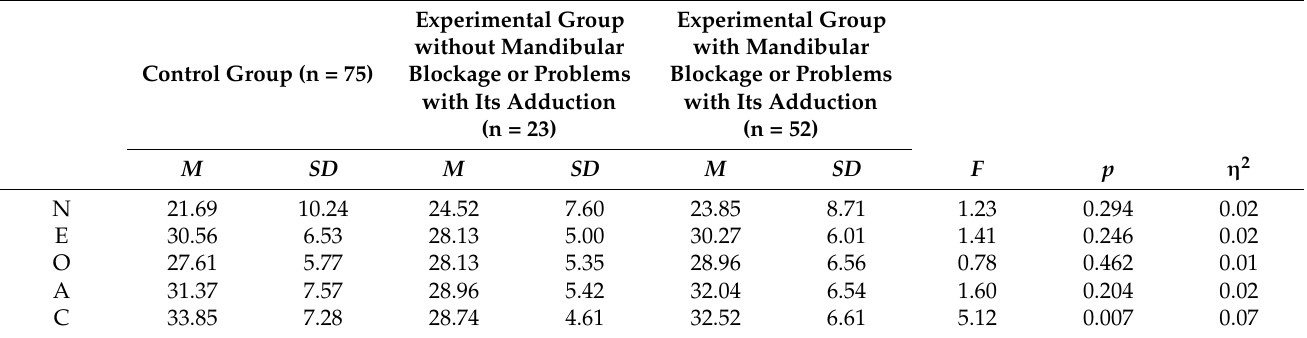
Table 4. The results of a one-way analysis of variance for mandible movement limitation upon